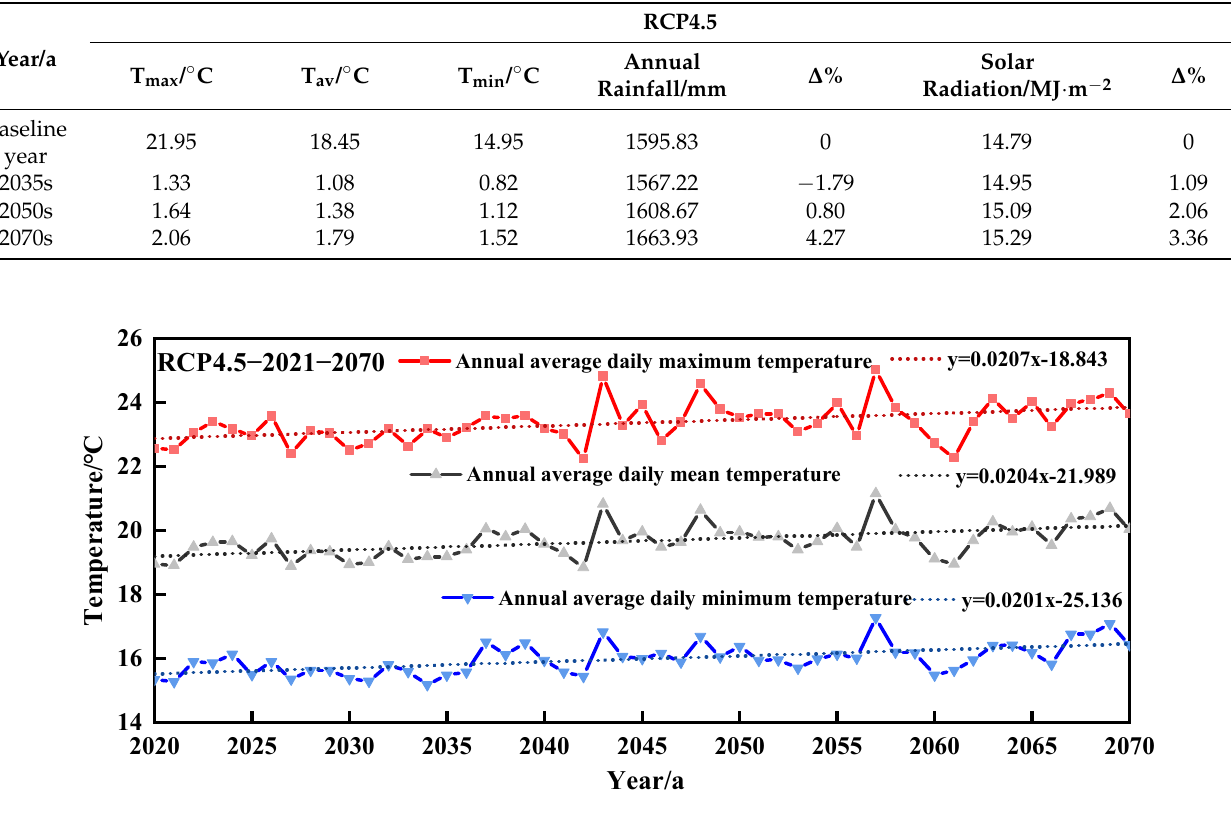
Figure 7. Forecast future meteorological temperature in Nanchang.